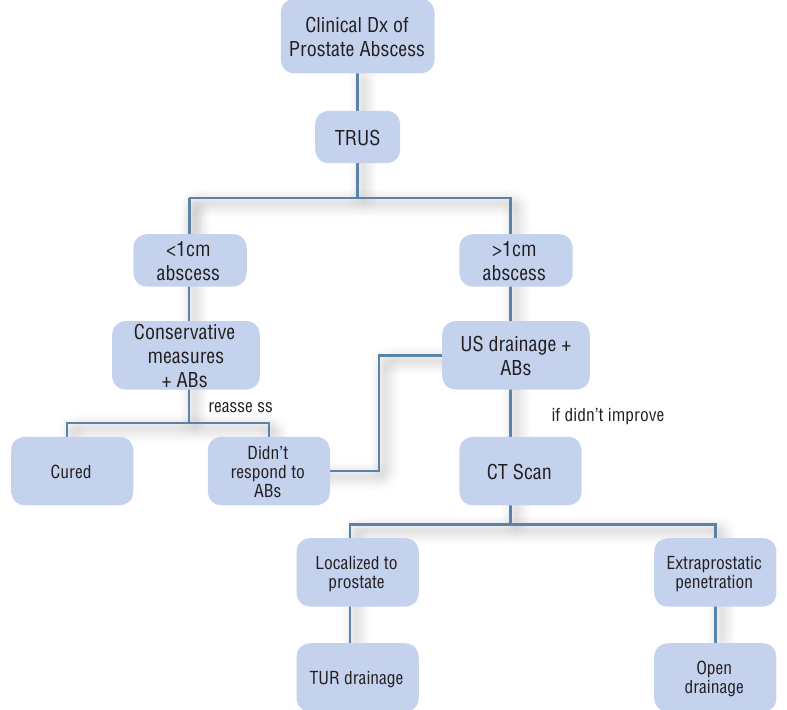
Figure 1 - Algorithm for management of prostate